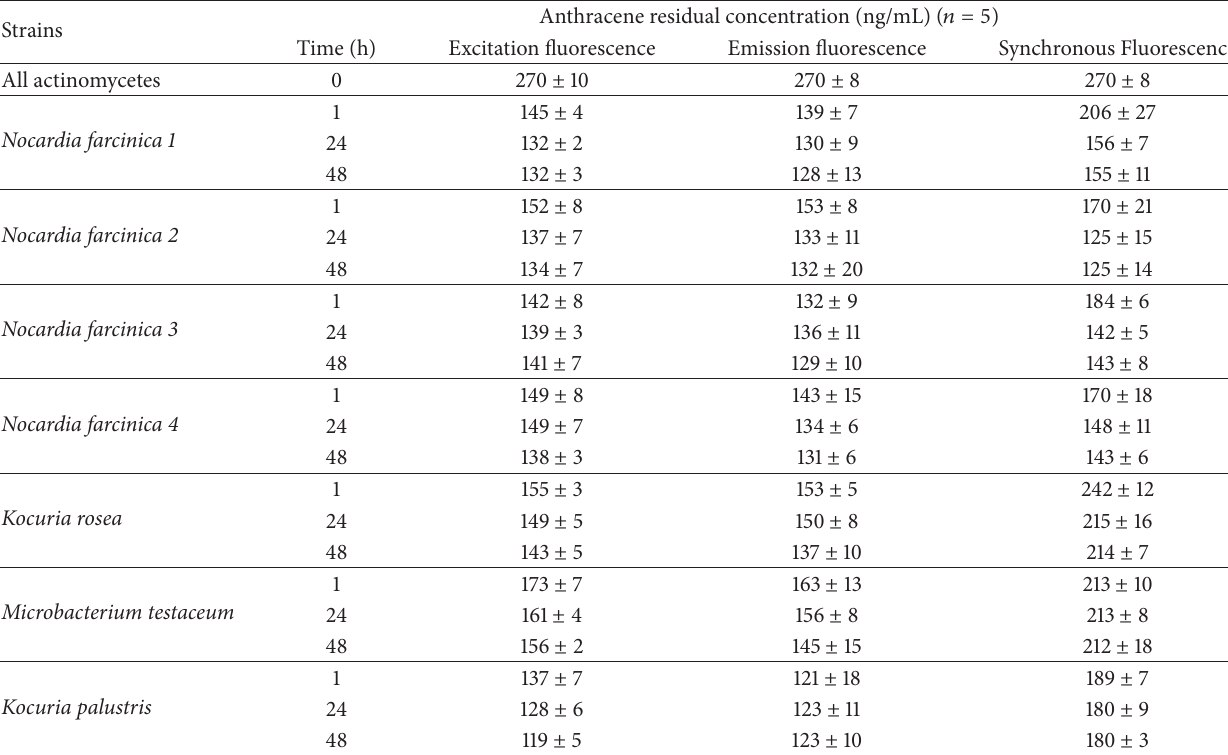
Table 2: Anthracene residual concentration in the cultured media inoculated with haloalkalitolerant actinomycetes by the three fluorescence methods. Strains All